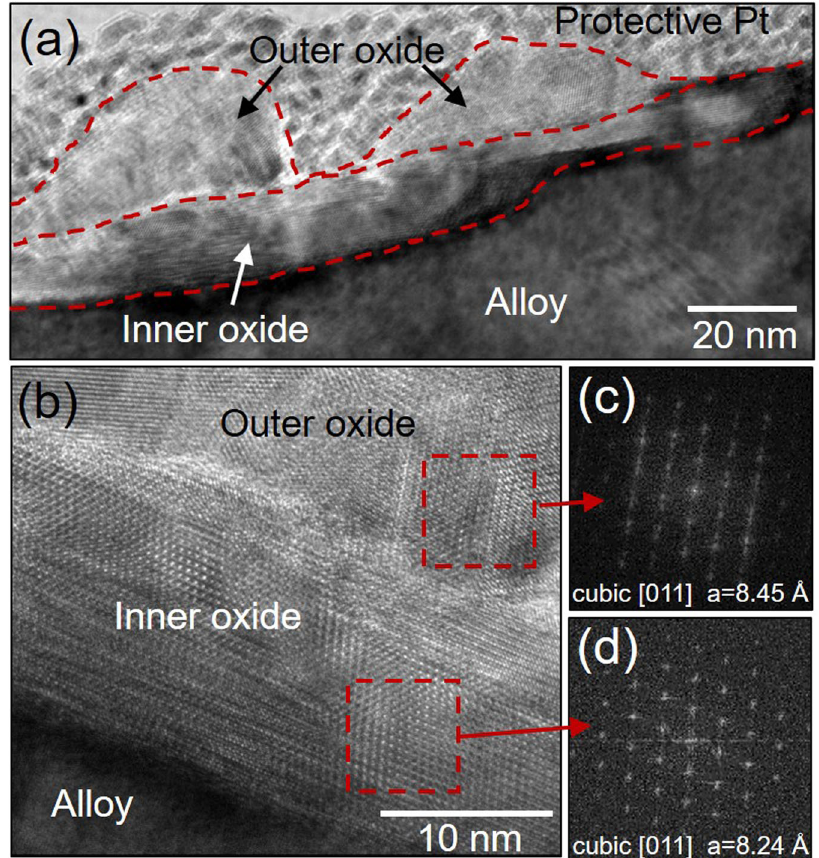
Fig. 4 Cross-sectional TEM analysis of Fe22Cr after AP-XPS in high purity CO 2 . a , b HRTEM images of the oxidized surface at low and high magni fi cations. c , d FFT patterns of outer and inner oxide layers corresponding to the regions indicated by red boxes in b different lattice parameters. We were unable to identify these phases by cross-referencing with the available crystallography database. Figure 5 shows a cross-sectional scanning TEM (STEM) image and corresponding energy-dispersive X-ray spectroscopy (EDS) maps of a typical region of the Fe22Cr sample. While it was not possible to differentiate the inner and outer oxide layer from the STEM images such as that shown in Fig. 5a, the interface could be inferred based on the nodule-type structure of the outer oxide layer, as revealed by the HRTEM images in Fig. 4a. This approximate interface, as well as the oxide surface and the oxide/alloy interface, are delineated by the white dashed lines in Fig. 5. The EDS maps in Fig. 5b – e indicate that both the inner and outer oxide layers are rich in Cr, while a relatively small amount of Fe is also distributed throughout both layers. A zone of Cr depletion that is ≈ 25 nm thick persists immediately below the oxide layer, consistent with the selective oxidation of Cr. Finally, Cr-rich particles appeared immediately below the Cr depletion zone (Fig. 5d), to a depth of ≈ 400 nm into the alloy. Both TEM and APT analyses con fi rmed these were α -Cr intermetallic precipitates, as shown in Supplementary Fig. 3. These particles are known to form in Cr-rich ferritic matrices at the temperatures used in this study, and therefore they are unrelated to the oxidation process 33 . Their close proximity to the alloy surface likely re fl ects that they precipitated at dislocations caused by the mechanical action of the polishing surface fi nish, the so-called “ cold-worked zone ” . Figure 5f shows an EDS pro fi le taken across the red line in Fig. 5a. Note that (1) the quanti fi cation was done without standards and